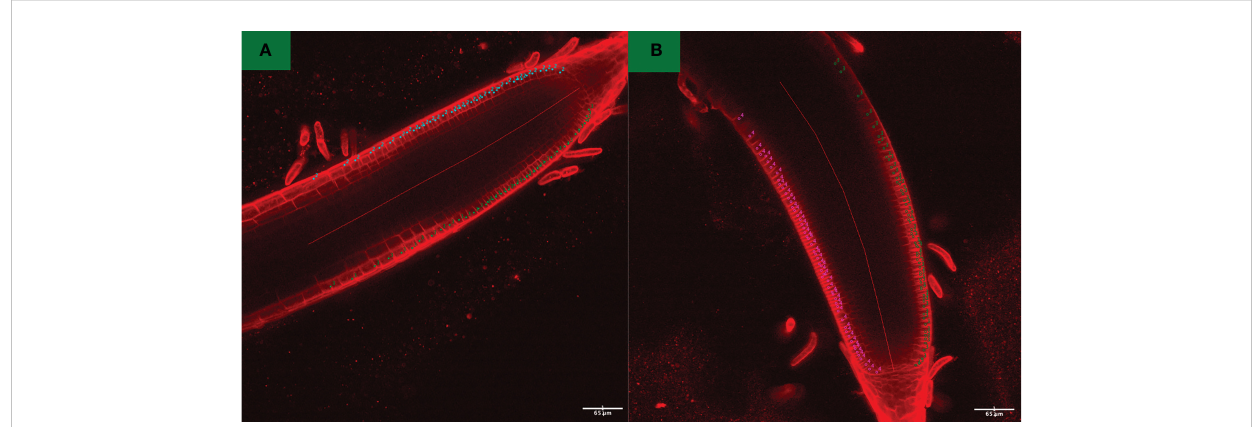
FIGURE 3 Confocal fl uorescence images of (A) indazi fl am-resistant (Site 18) and (B) indazi fl am-susceptible (S1) P. annua , treated with FM4-64 dye and post- acquisition processed using FIJI function enhance contrast, with equalize histogram enabled. Cell counter plugin was utilized for counting the number of cells in the fi xed length (500 pixels) from the quescient center of roots. These count data are presented in Figure